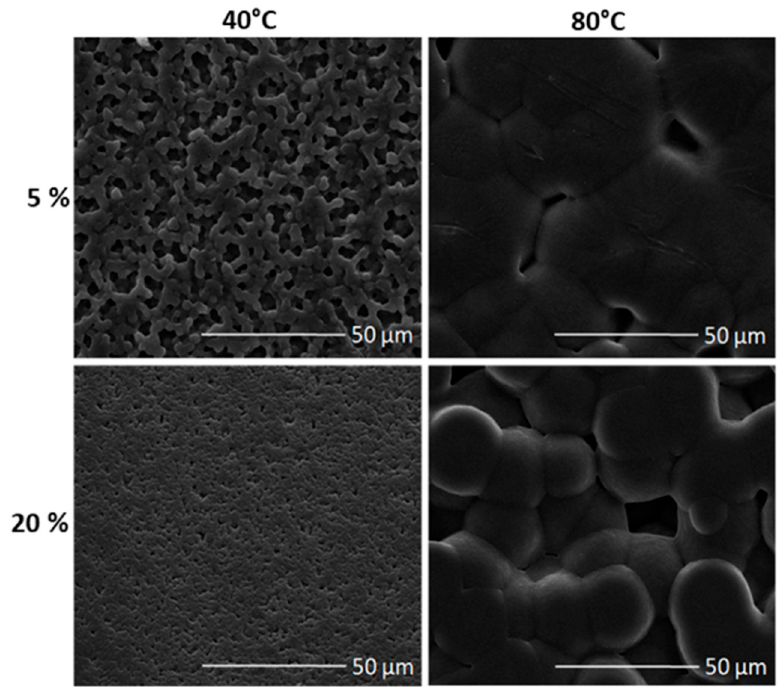
Figure 1. Qualitative analysis of surface morphology of PVDF films: SEM images of samples from polymer solutions with different concentration (i.e., 5 and 20%) and treated by different casting temperature (i.e., 40 and 80 °C) .